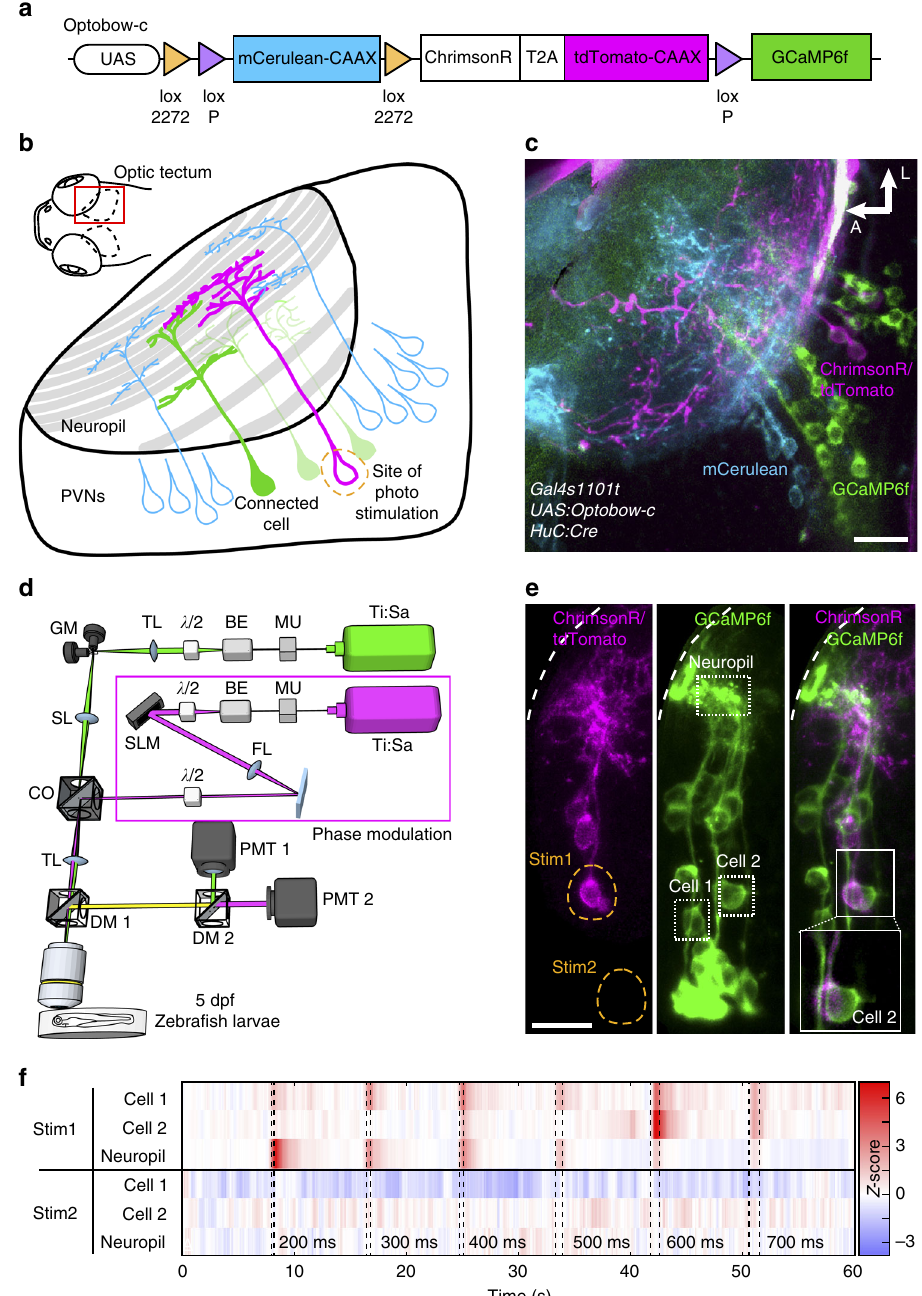
Fig. 1 Optobow allows all-optical mapping of connected neurons. a Design of the Optobow-c construct. mCerulean and tdTomato are both membrane- targeted (CAAX motif). b Sketch for Optobow-c expression in the zebra fi sh optic tectum. Different cell types are indicated by their arborization patterns in the tectal neuropil. Addition of Cre by transient injections results in random expression of either ChrimsonR (labeled by tdTomato, magenta ) or GCaMP6f ( green ). Unrecombined cells are labeled by mCerulean ( blue ). Upon photostimulation of a single ChrimsonR cell ( dashed orange outline ) connected cells will be highlighted by a rise in GCaMP fl uorescence ( dark green cell ). c In vivo tectal expression of Optobow-c. Scale bar, 20 µ m. d Microscope setup for all- optical connectivity mapping. Two independent infrared-pulsed lasers are used to photostimulate ChrimsonR cells ( magenta ) and to image GCaMP fl uorescence ( green ), respectively. A spatial light modulator (SLM) allows precisely targeted stimulation of single cells. See methods for abbreviations. e Dorsal view of tectal Optobow-c expression. Single fl uorescent channels show a cluster of three ChrimsonR- ( left ) and 18 GCaMP6f-expressing cells ( middle ). Photostimulation was either con fi ned to a single ChrimsonR cell (Stim1, dashed orange outline ) or to a control region of equal size (Stim2). White dashed line marks skin. Dotted rectangles show regions of calcium imaging during photostimulation. A close-up showing a single confocal plane ( z = 2.5 µ m) of the photostimulated region (Stim1) is shown in the merge on the right . Despite the close proximity of the ChrimsonR and the GCaMP cell#2, exclusive expression of either component allows restricted stimulation of the ChrimsonR-expressing cell. Scale bar , 15 µ m. f Calcium transients acquired at 10 fps shown as Z -scores, obtained simultaneously from the regions indicated in e . Photostimulation events are highlighted by dashed lines with stimulation lengths indicated below. Off-target stimulation did not result in signi fi cant GCaMP activity (Stim2)